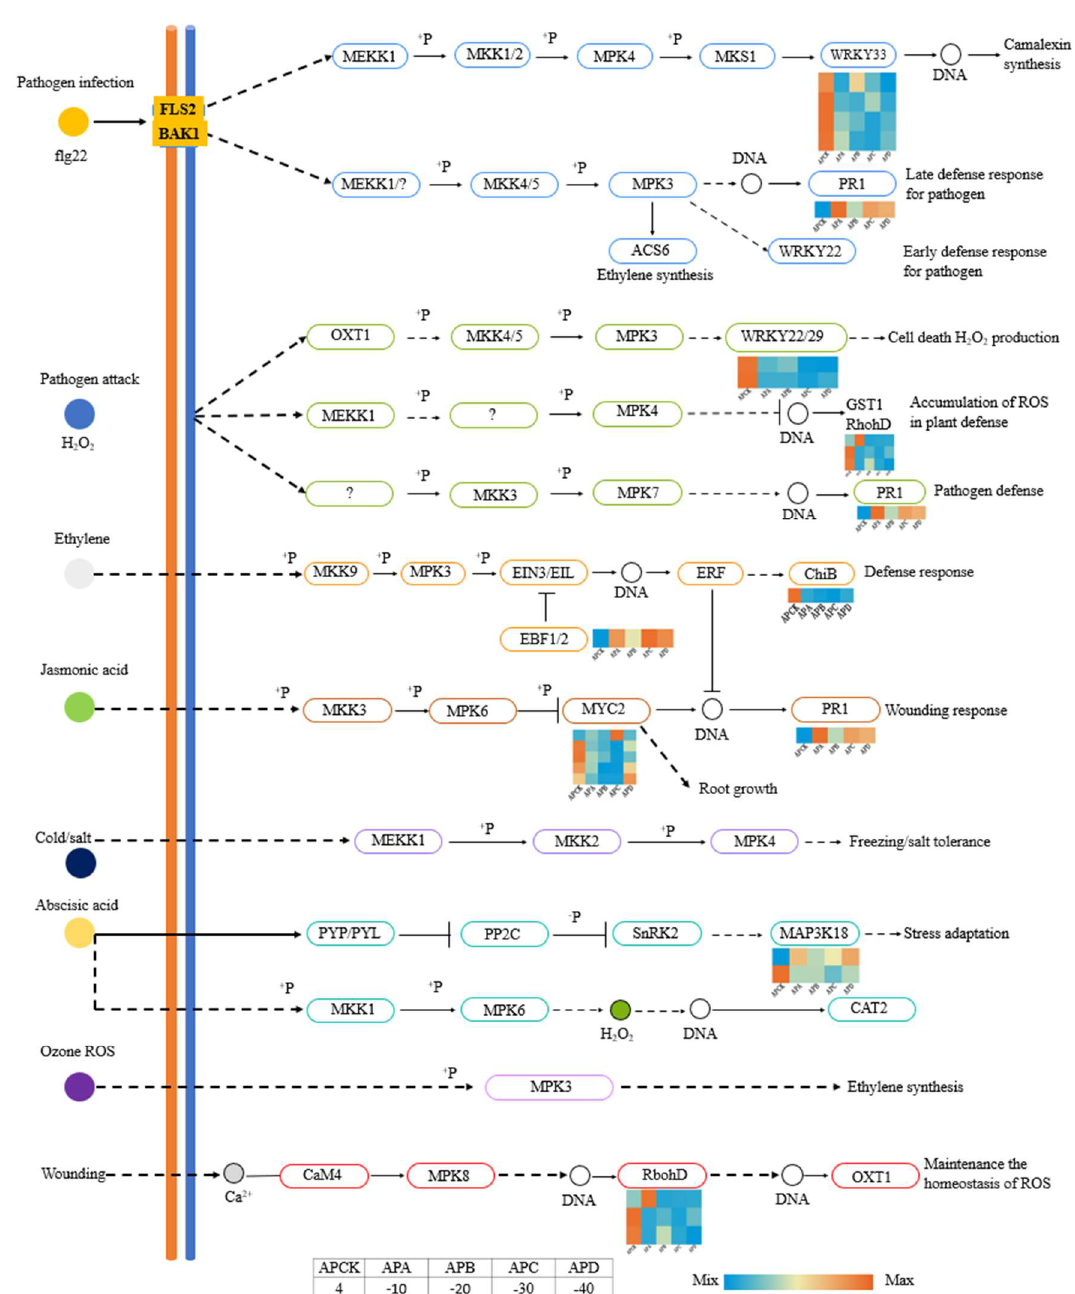
Figure 6. Expression of DEGs on MAPK pathway in A. pseudosieboldianum under freezing stress at different temperatures. The heatmap expression shows the differential gene expression of A. pseudosieboldianum under freezing stress at different temperatures compared to CK (4 °C).